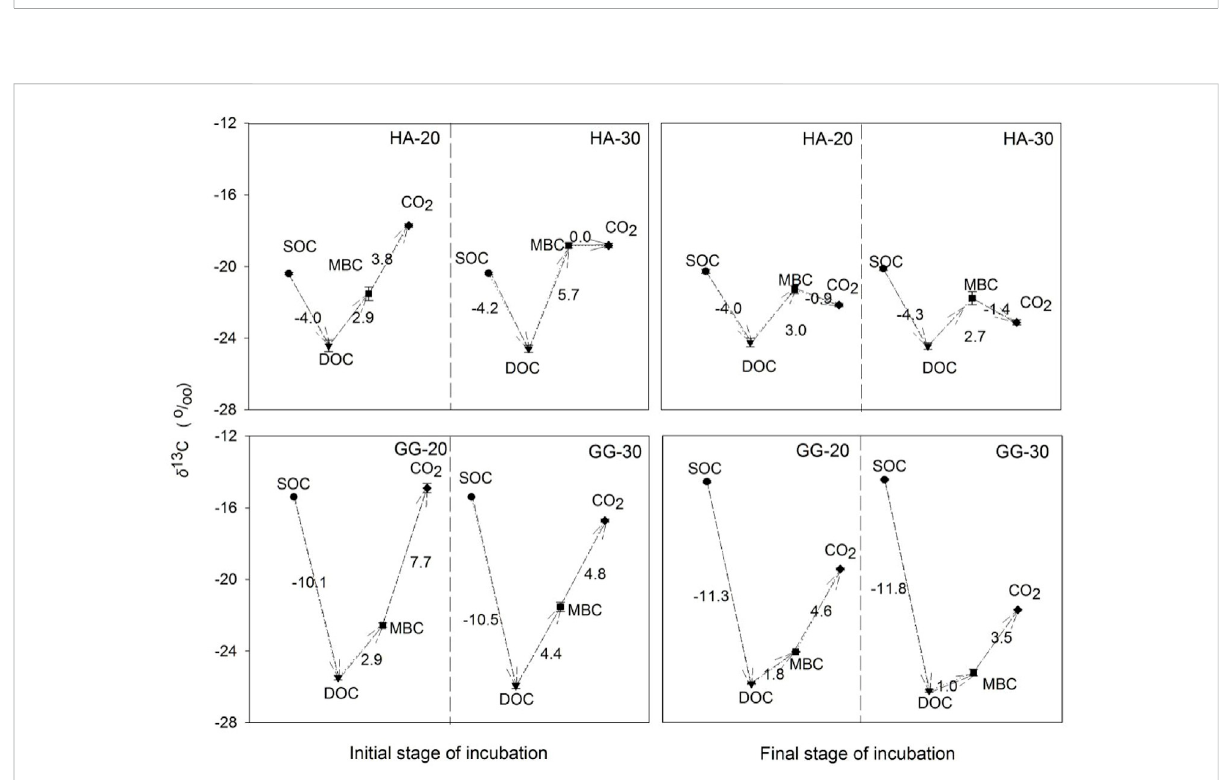
FIGURE 3 Changes in the δ 13 C signature of C pools during the 1-year incubation. Values are presented based on δ 13 C of C pools in the soil after C 3 -C 4 vegetation change. We assumed that the transformations go in the following direction: SOC → DOC → MBC → CO 2 . Error bars show ±SE ( n =